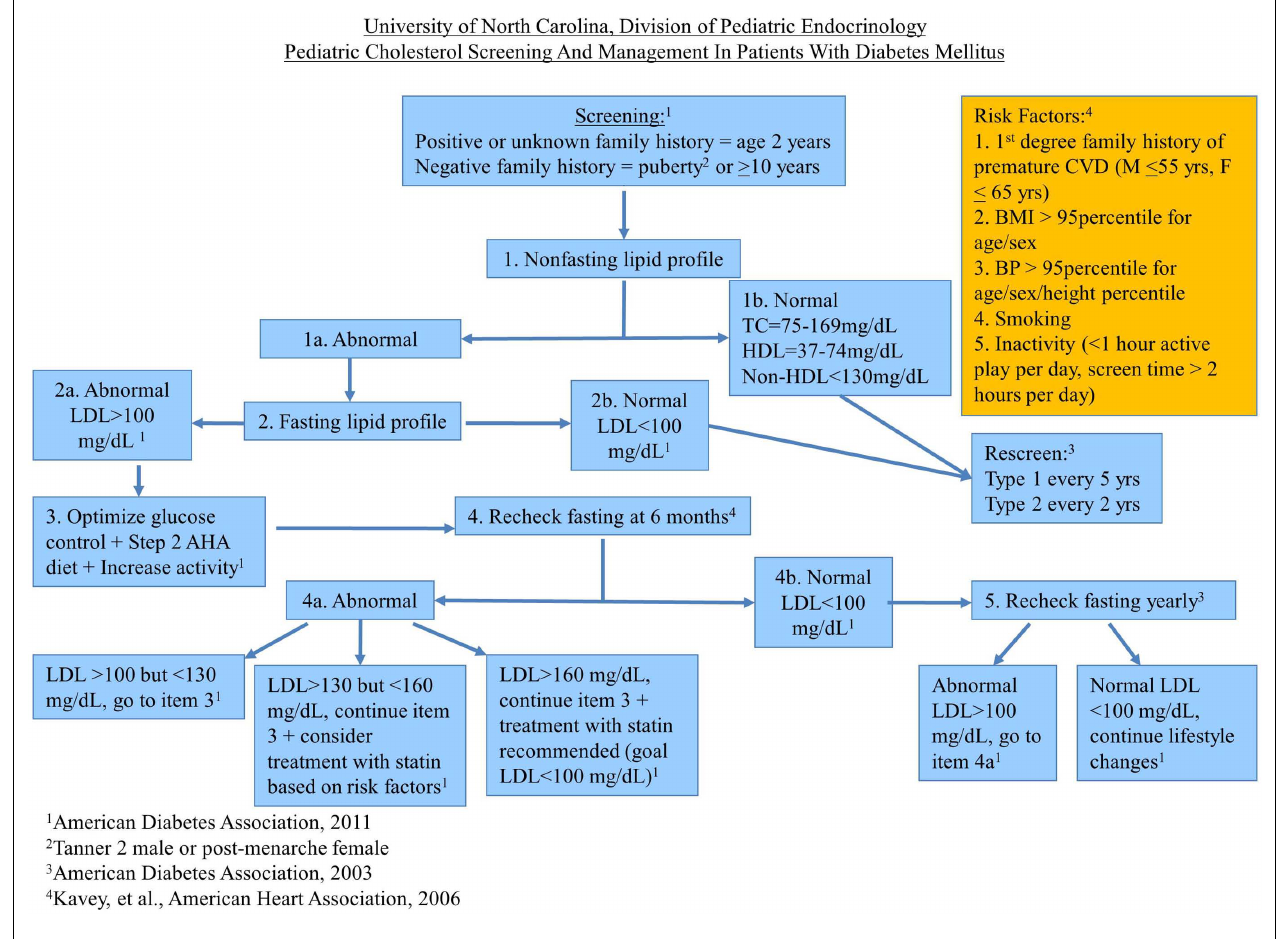
FIGURE 1 | University of North Carolina-Chapel Hill pediatric endocrinology cholesterol algorithm.